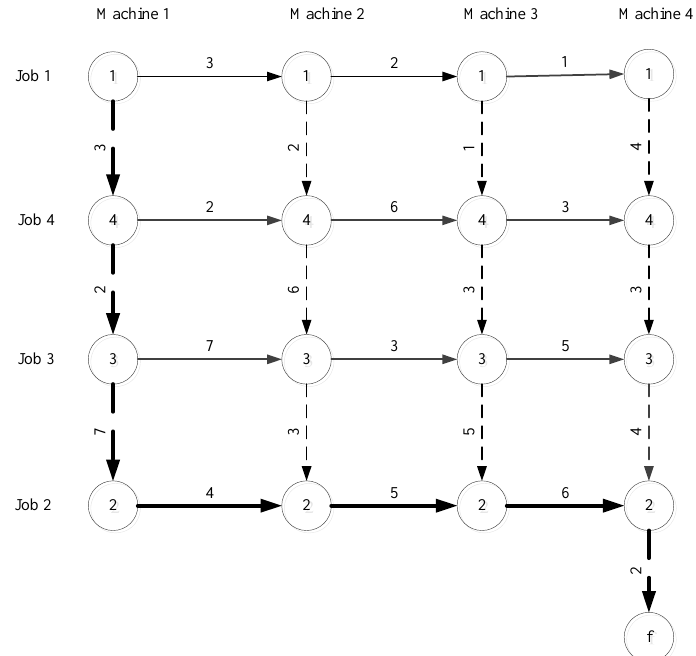
Figure 2. Changing the order of (1,2,3,4) to (1,4,3,2) in the sample problem and obtaining the optimal solution with the makespan of